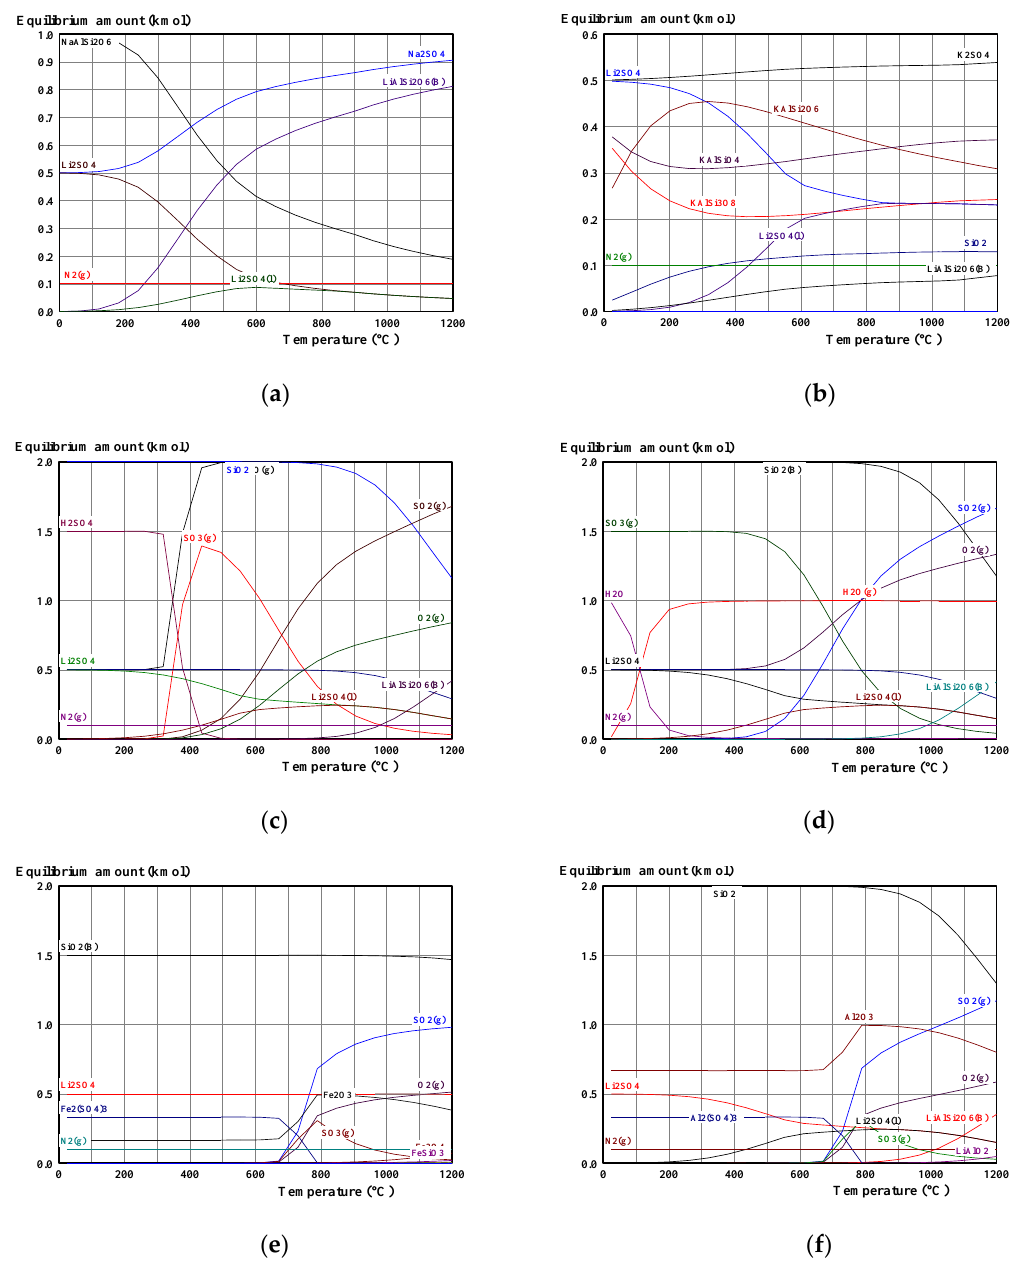
Figure 3. Equilibrium amounts versus temperature for sulfate roasting of spodumene using ( a ) Na 2 SO 4 , ( b ) K 2 SO 4 , ( c ) H 2 SO 4 , ( d ) SO 3(g) , ( e ) Fe 2 (SO 4 ) 3 and ( f ) Al 2 (SO 4 ) 3 (data from HSC Chemistry 5.1 software).